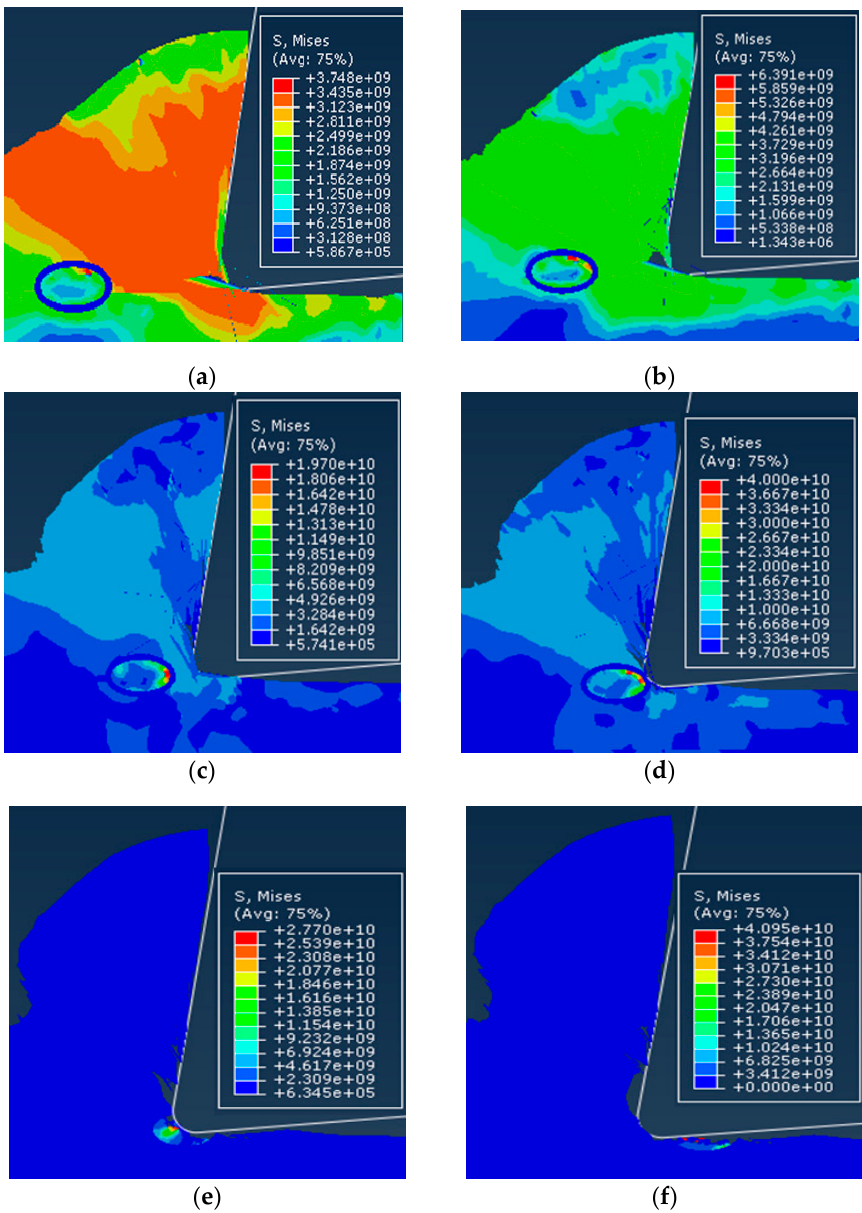
Figure 21. Model II simulation cutting process: ( a ) Stress concentration in the particle, ( b ) interfacial failure tool contact particle, ( c ) particle breakage, ( d ) increased particle breakage area, ( e ) complete particle removal, and ( f ) residual particle remain on the cutting surface.